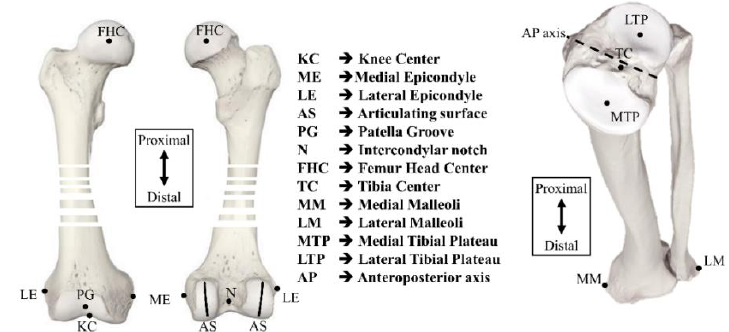
Figure 1. Anatomical points required for TKA [41]: femur and tibia.